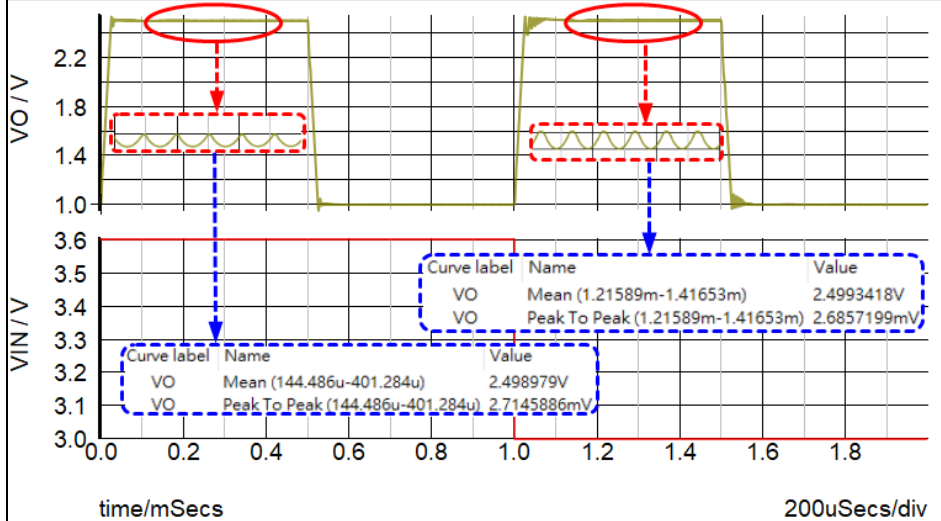
Figure 8. Performance over a wide input